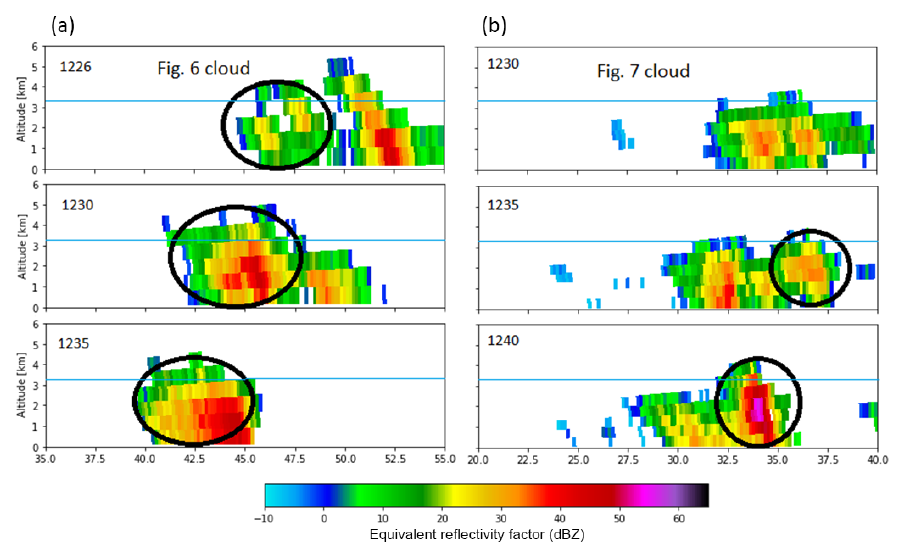
Figure 8. Time series of pseudo-range height indicator (RHI) plots of NCAS radar reflectivity during Case B through the cloud in Fig. 6 (a) and in Fig. 7 (b) . Circle indicates the location of the cloud penetrated by the UWKA. The blue line indicates location of 0 ◦ C